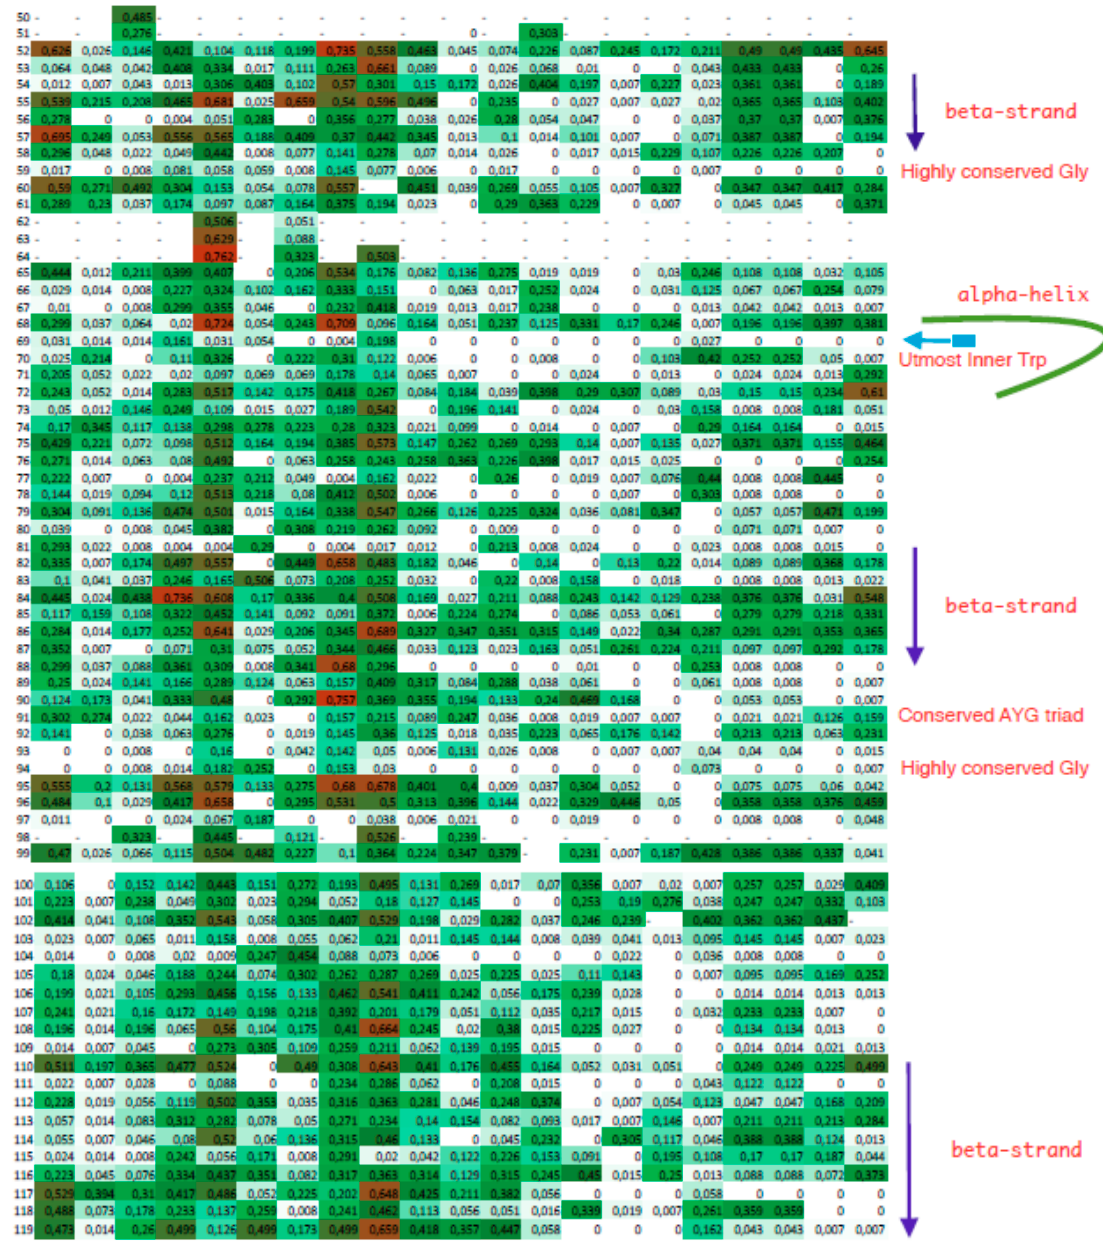
Figure 3. Heat-map of the FKBPs encoded in various genomes. Fk1a and Fk1b—FKBP12a and FKBP12b, respectively; Fk3—FKBP25; Fk4a and Fk4b, N-terminal and C-terminal FKBDs in FKBP52; Fk5a and Fk5b, as above for FKBP51; Fk2, Fk7, Fk11, Fk14 correspond to endoplasmic reticulum specific FKBPs, namely FKBP13, FKBP23, FKBP19, and FKBP22, whereas Fk9a, Fk9b, Fk9c and Fk9d as well as Fk10a, Fk10b, Fk10c and Fk10d correspond to the four FKBDs starting from the N-terminus of FKBP63 and FKBP65.